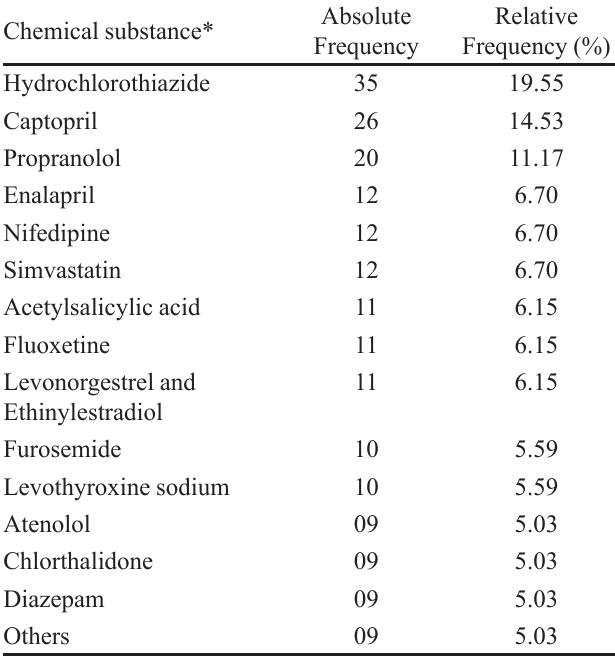
TABLE IV - Absolute and relative frequencies of inappropriate drug use according to Beers criteria by